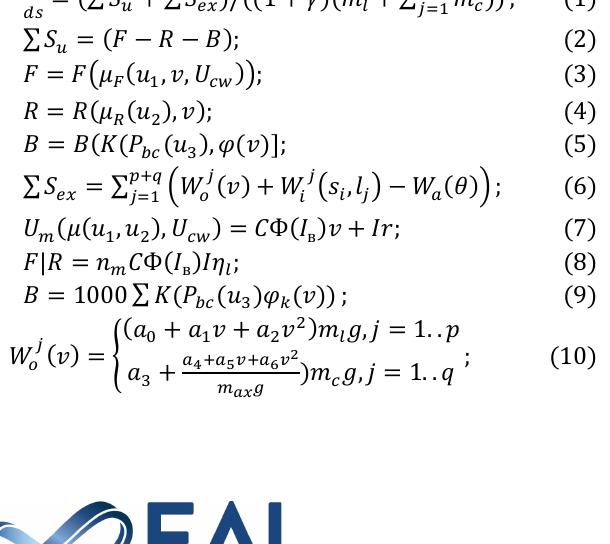
Fig. 2. Here are the basic functional units of the model: simulation traction, recuperation and mechanical braking; forces of the main and additional resistances to motion; blocks of modeling the mechanical motion of a train, input data, restrictions of speed, regulation of speed and time motion and optimal programs; auxiliary units for imaging parameters, calculation of power consumption